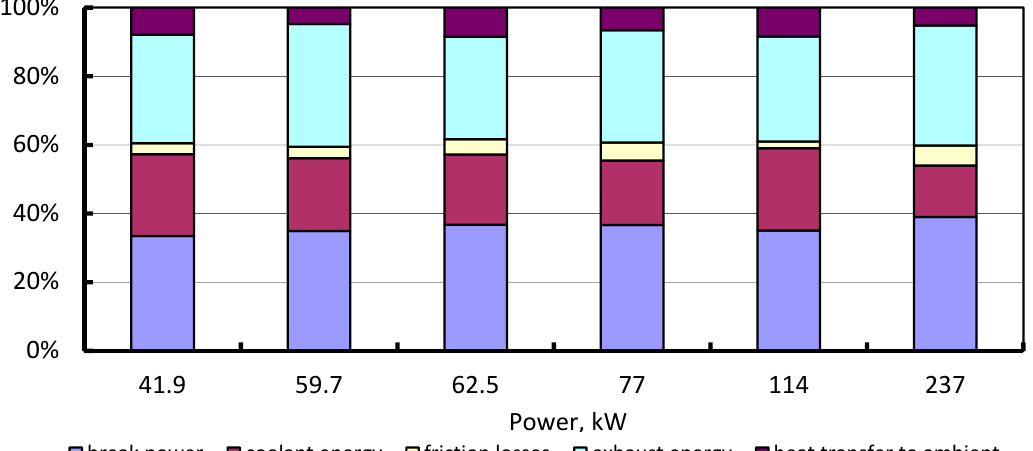
Figure 1. The energy balance of internal combustion engines. Source: adapted from [5,6].